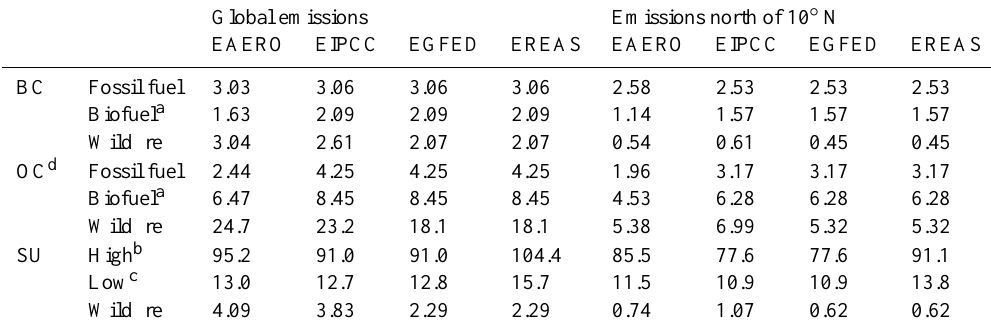
Table 2. Anthropogenic emissions for each emission dataset (in [Tgyr − 1